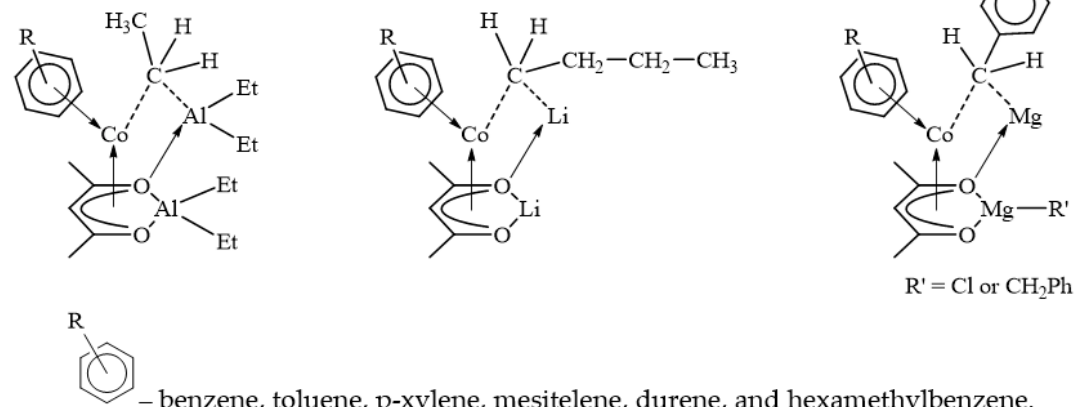
Figure 12. Models of bimetallic paramagnetic complexes formed during the interaction of components of systems based on Co(acac) 2 and Red (where Red = AlEt 3 , Li- n -Bu, (PhCH 2 )MgCl). The model with AlEt 3 taken from [69,77].